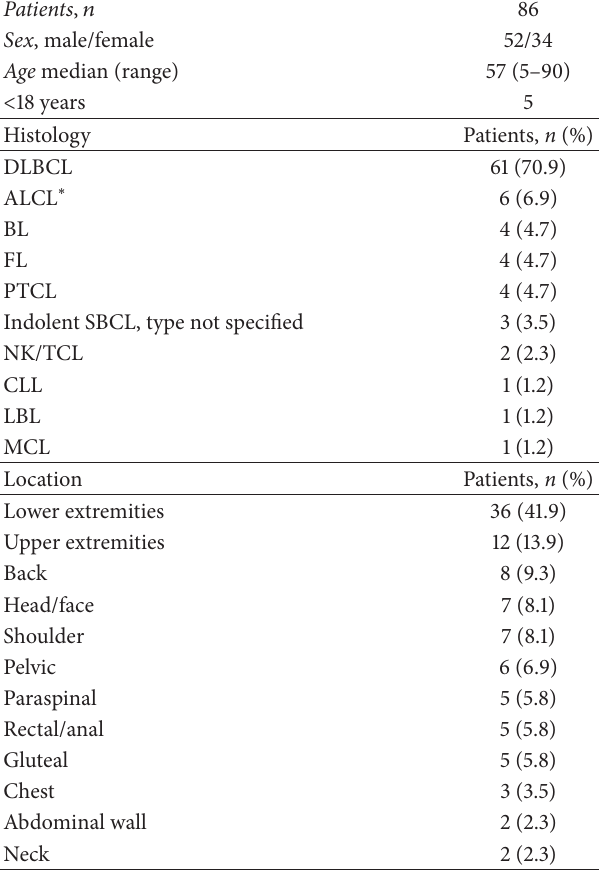
Table 2: Clinicopathologic characteristics of 86 patients from the literature with reported muscle